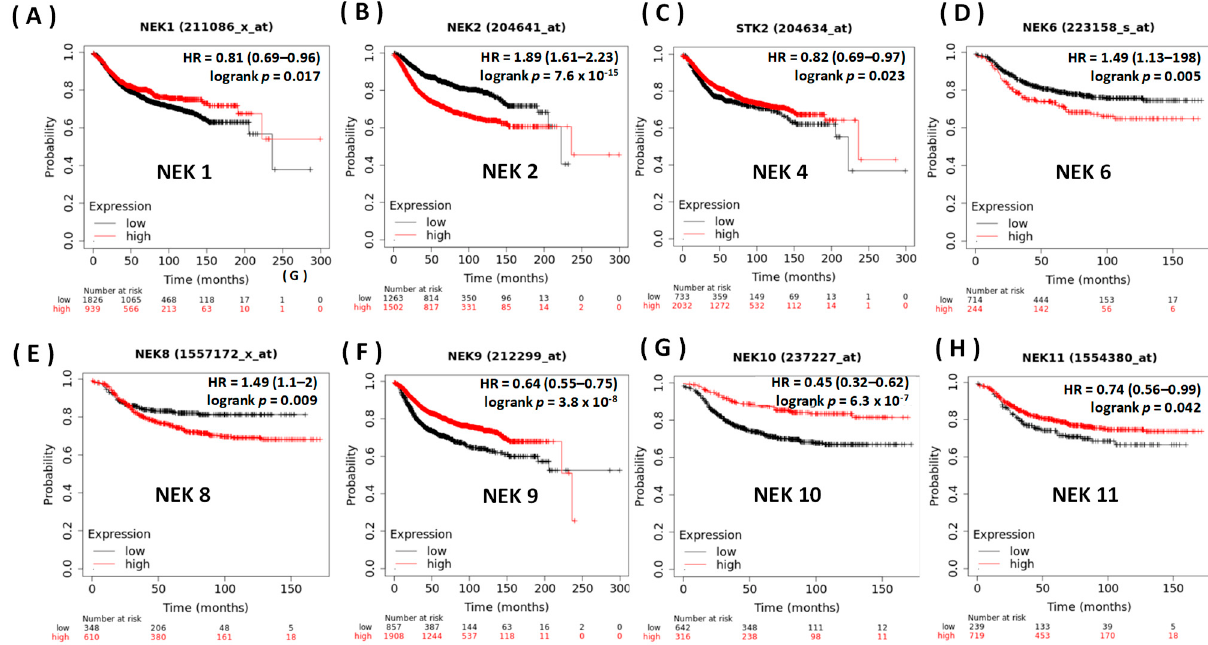
Figure 5. Survival curve of the NEK gene family on distant metastasis-free survival (DMFS) in breast cancer patients (Kaplan-Meier plotter). The hazard ratio (HR) is a relative prognostic measure of patients with breast cancer. logrank p was used to determine the level of prognostic significance of patients with breast cancer. Furthermore, the logrank p < 0.05 was interpreted as a significant difference in the prognostic expression of patients with breast cancer.